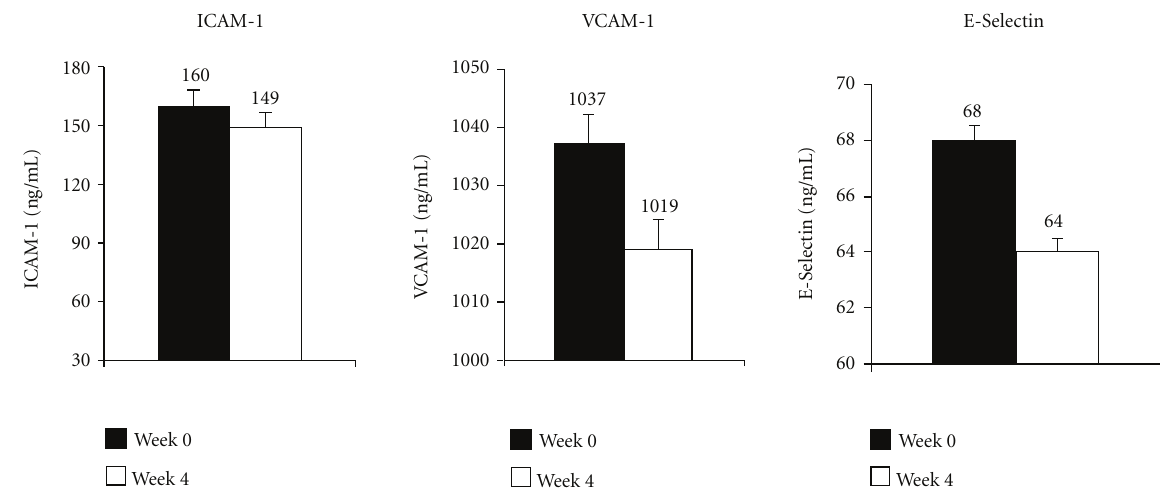
Figure 4: Mean values of intracellular adhesion molecule-1 (ICAM-1), vascular cell adhesion molecule-1 (VCAM-1), and E-selectin at baseline (week 0) and at the end of the study (week 4) ( n =